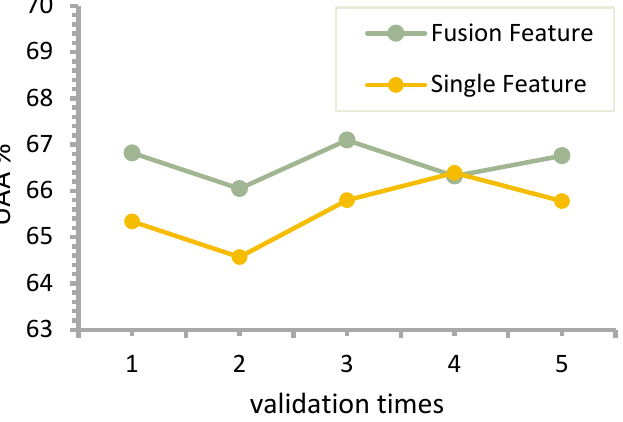
Figure 10. Comparison of MHA-CRNN and its feature fusion model in IEMOCAP. (4)